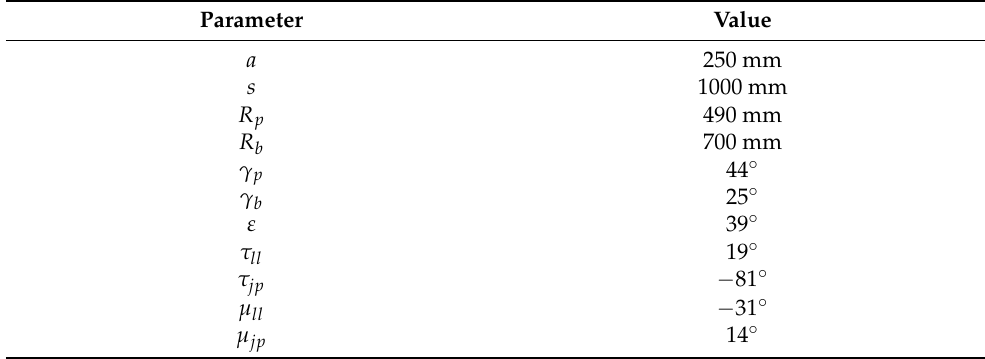
Table 6. Values of geometric parameters for the final